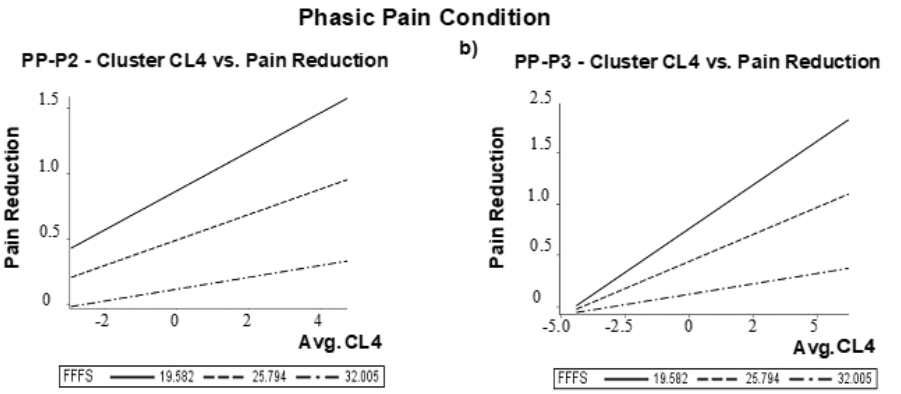
Figure 8. Moderator effect of FFFS on the Cluster 4 (CL4) for the Phasic Pain condition: difference vs. Pain reduction for ( a ) PP-P2 amplitude; ( b ) PP-P3 amplitude difference scores.